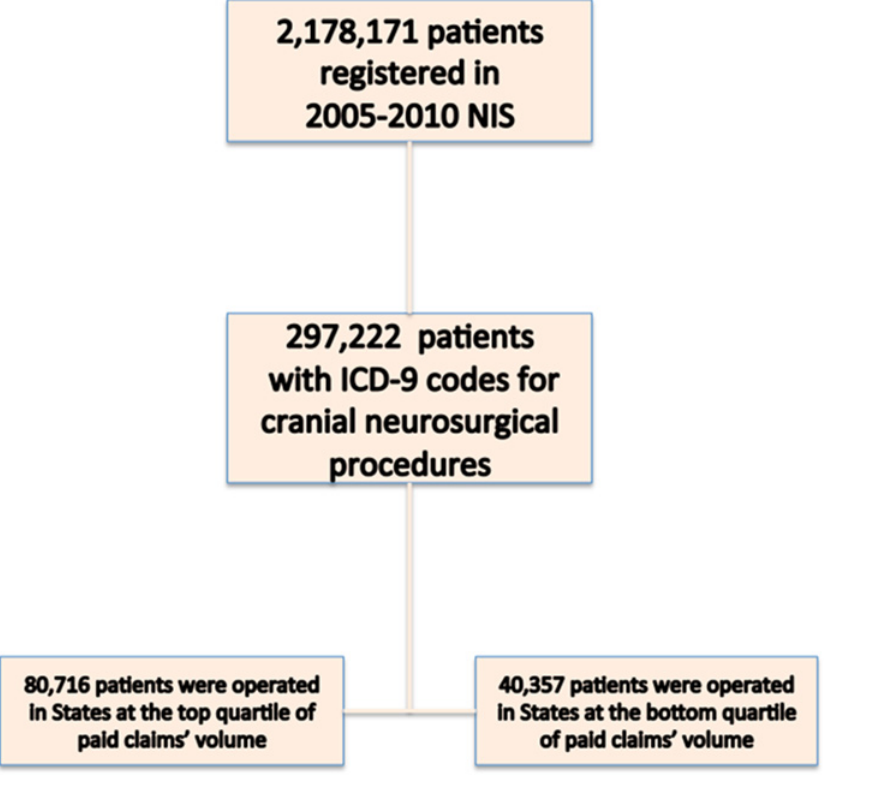
Fig 1. Cohort selection for the